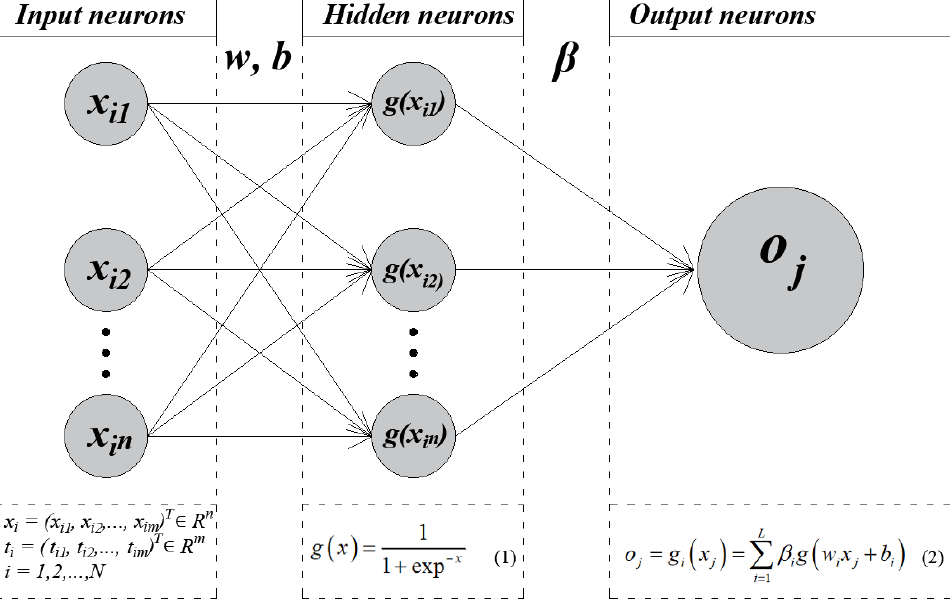
Fig. 2. Structure of the